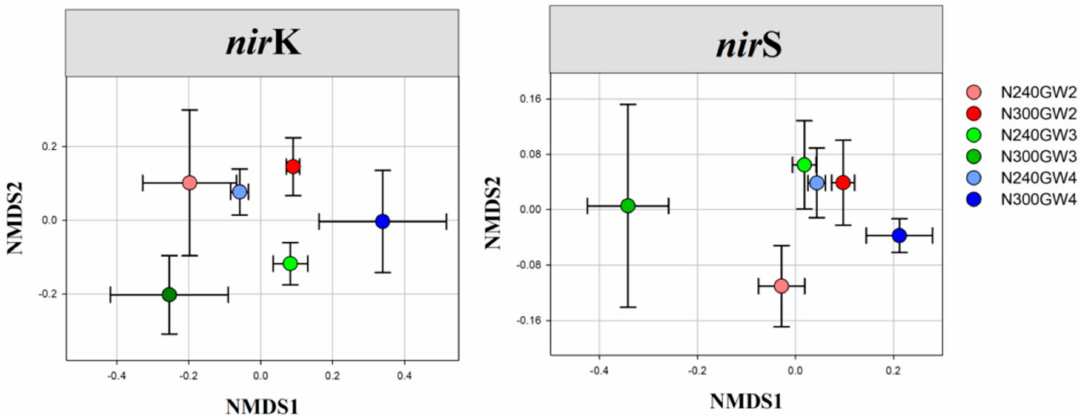
Figure 4. Nonmetric multidimensional scaling (NMDS) ordination of nir S-type and nir K-type community di ff erences (Bray–Curtis distance) under di ff erent groundwater table conditions and reduced nitrogen application